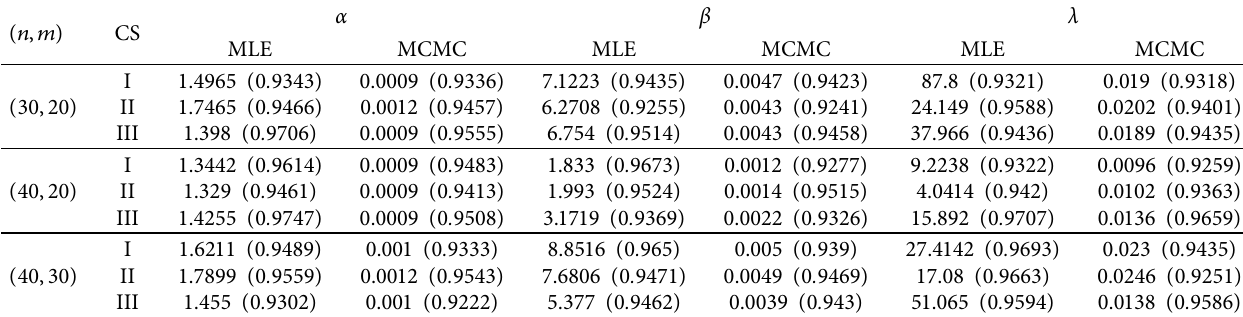
Table 9: ACL and CP of 95% CIs for the parameters α , β , and λ .